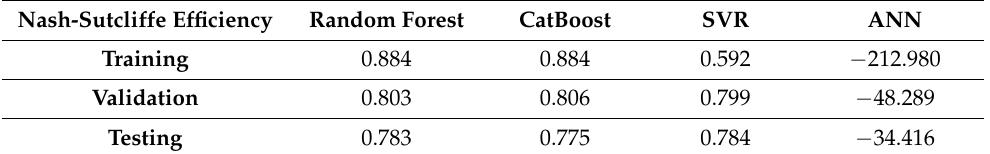
Table 5. Prediction accuracy result of Nash-Sutcliffe Efficiency for different Machine learning